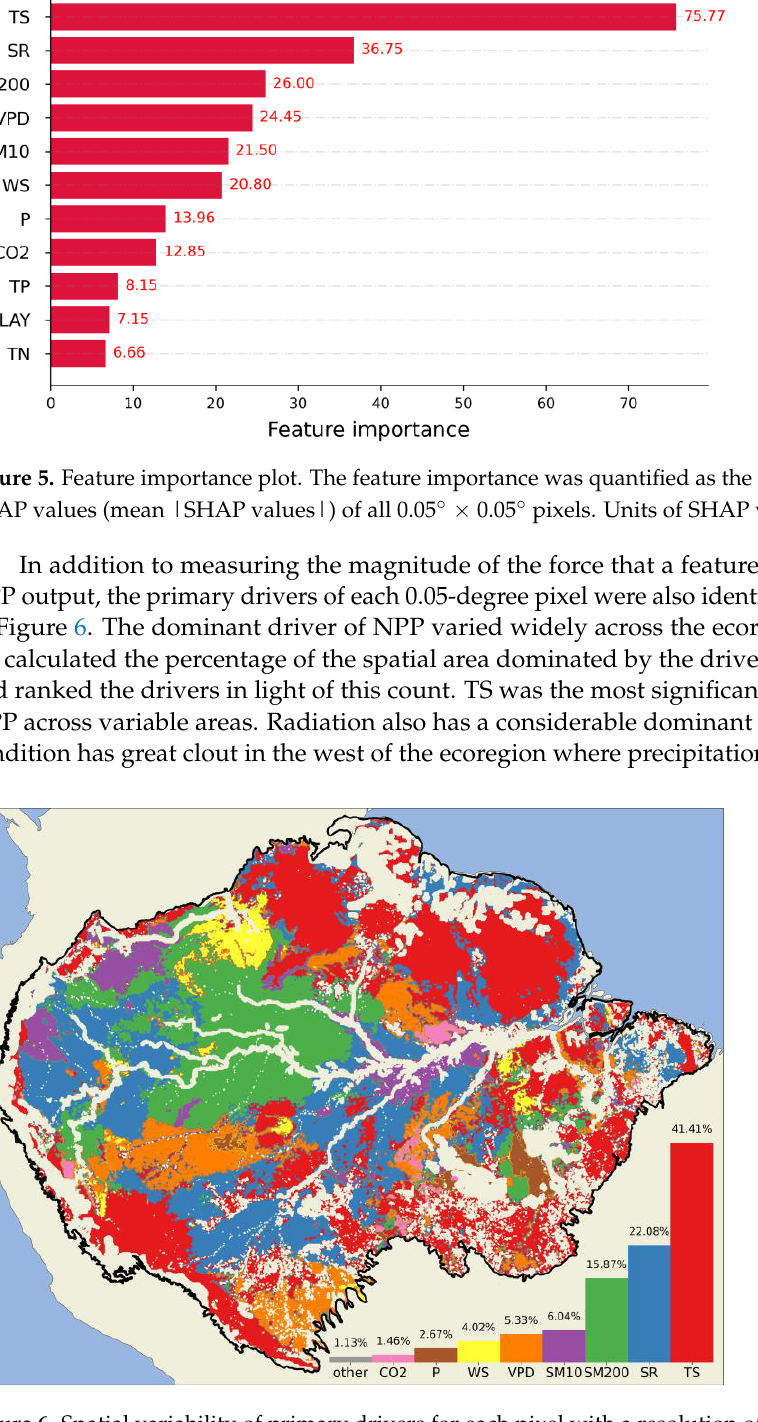
Figure 4. Spatial distribution of SHAP values for each 0.05° × 0.05° sample of ( a ) TS, ( b ) SR, ( c ) VPD, ( d ) SM200, ( e ) SM10, ( f ) WS, ( g ) CO 2 , ( h ) P, ( i ) CLAY, ( j ) TN, and ( k ) TP. Units of SHAP values: g C/m².